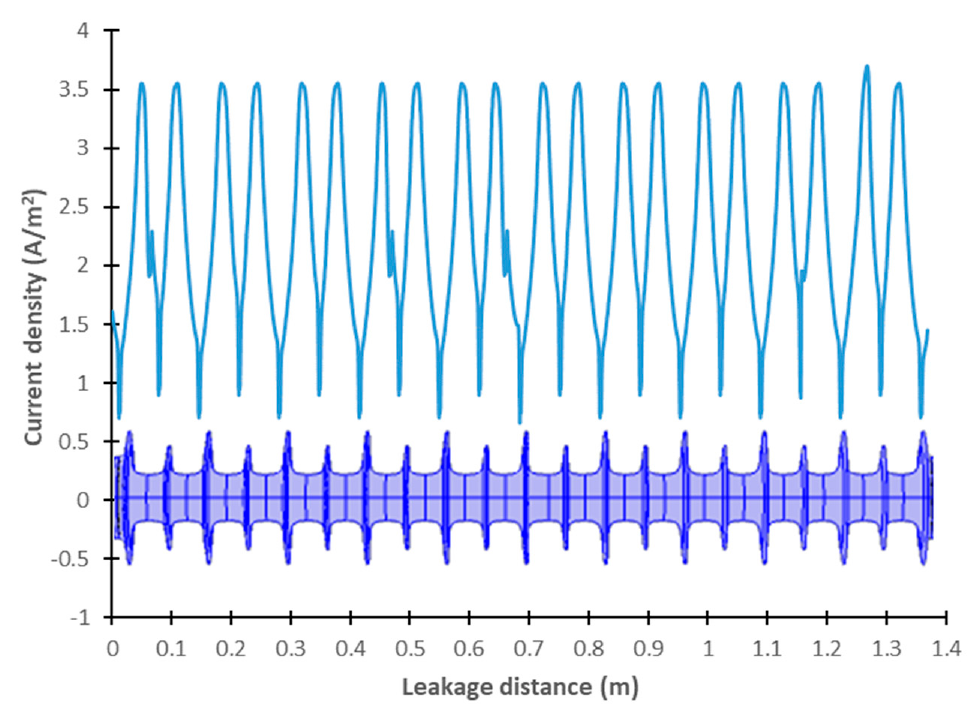
Figure 3. Current density distribution.